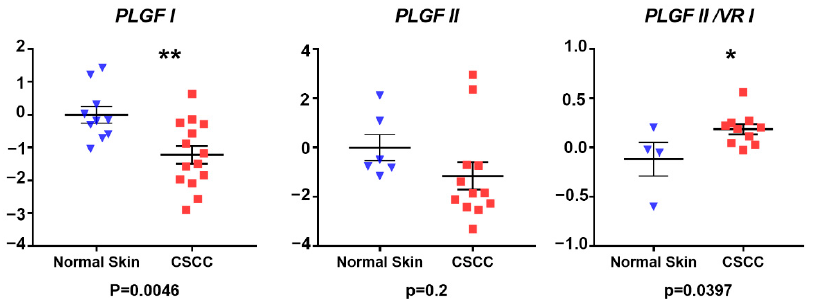
Figure 4. PLGF relative gene expression . mRNA expression of PLGF I and PLGF II splice variants was estimated by qRT-PCR in cDNAs derived from FFPE sections of NHS and CSSC tissue. Results are shown for the individual growth factors as relative to mean 18S rRNA-normalized expression in NHS controls, calculated using ΔΔ Ct method; similarly, PLGF variant ratios were calculated by internal normalization to PLGF I. Vertical axes represent expression in CSSC relative to NHS on a log 10 scale. Blue triangles represent normal skin samples; red squares represent CSCC samples p values are from two-sided unpaired Student’s t -tests.